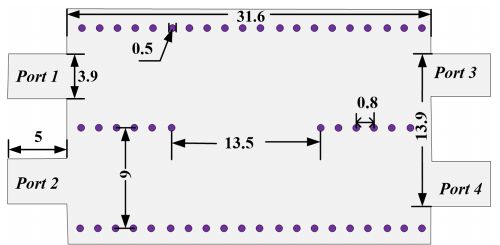
Figure 4. The optimized dimensions for the proposed 3 dB SIW coupler (unit: mm).